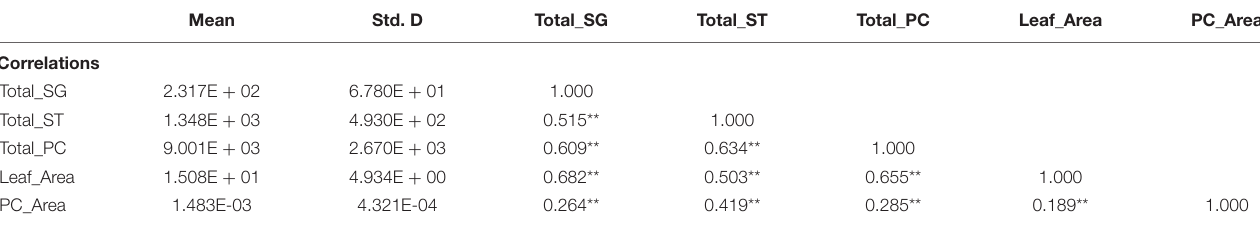
TABLE 1 | Correlation analysis between total salt glands (Total_SG) and the other four parameters: total stomata (Total_ST), total pavement cells (Total_PC), leaf area (Leaf_area), and pavement cell area (PC_Area) upon treatment with the five phytohormones salicylic acid (SA), brassinolide (BL), methyl jasmonate (MeJA), gibberellic acid (GA), and abscisic acid (ABA) using Pearson’s correlation analysis. Mean Std.